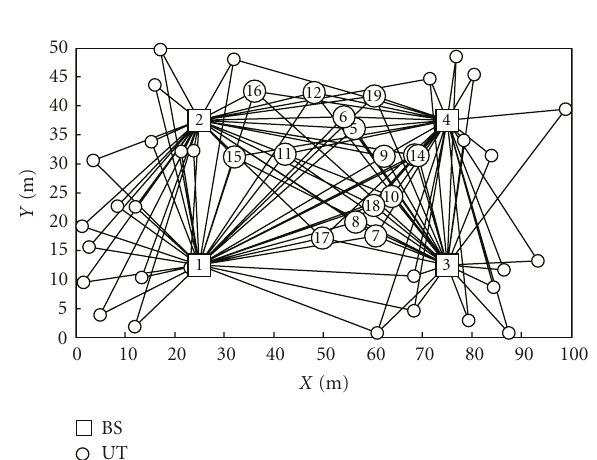
Figure 8: Considered indoor network topology.